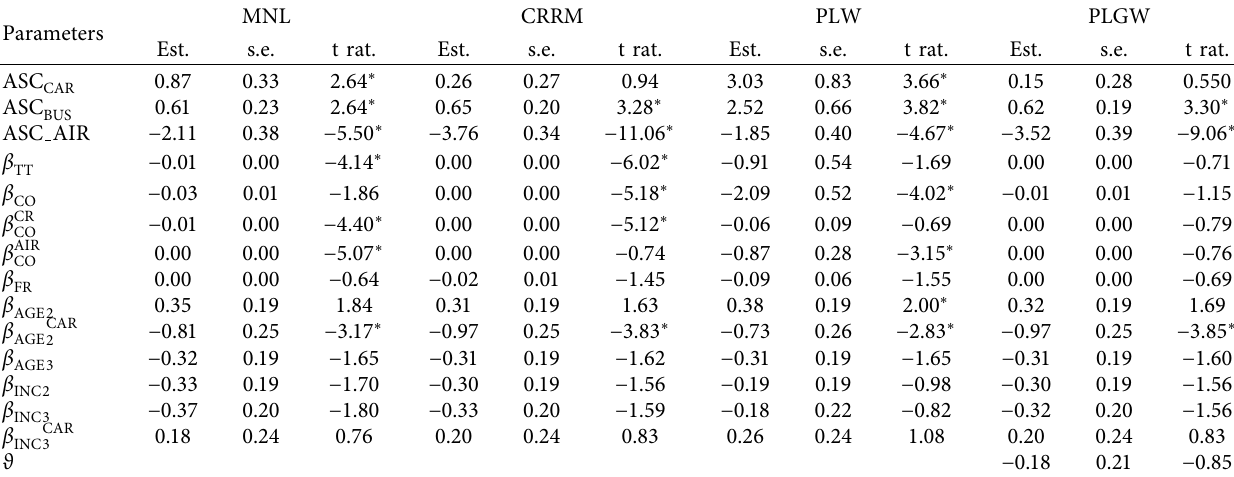
Table 6: Estimates of the CRRM, PLW, and PLGW for business purpose of the CR experiment. Parameters